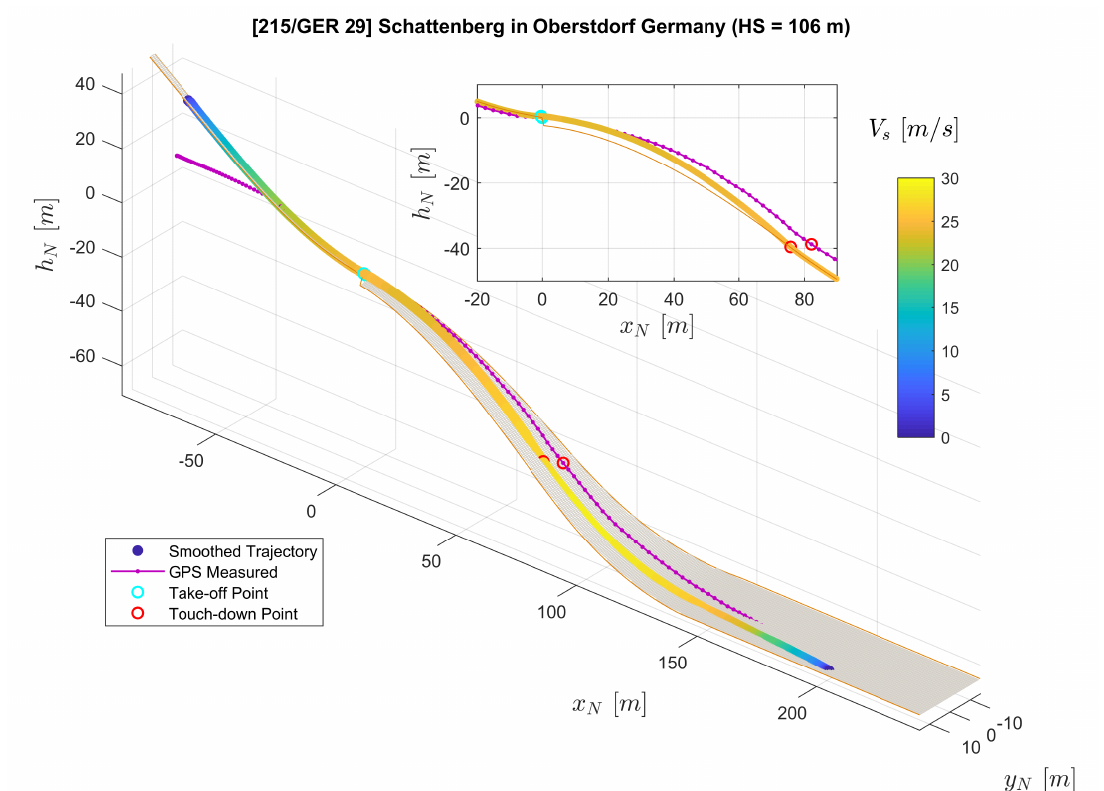
Figure 15. Trajectory Reconstruction result for Jump No.